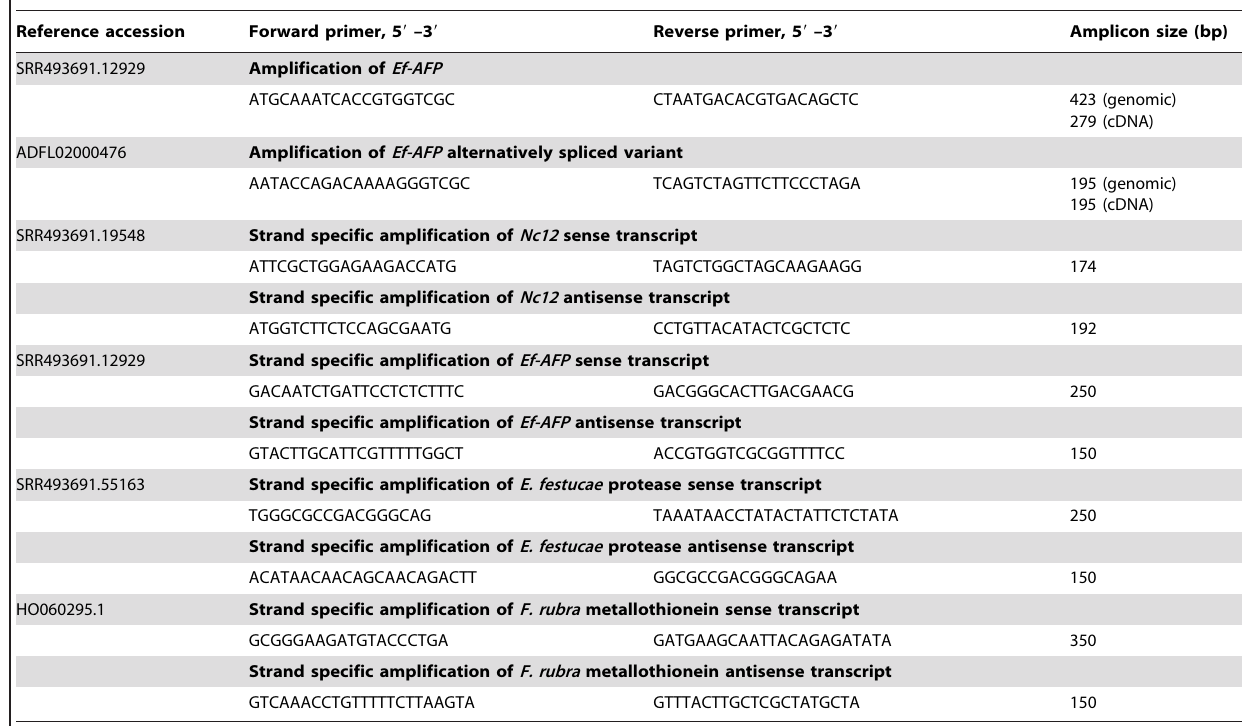
Table 6. Sequences of oligonucleotide primers used in this